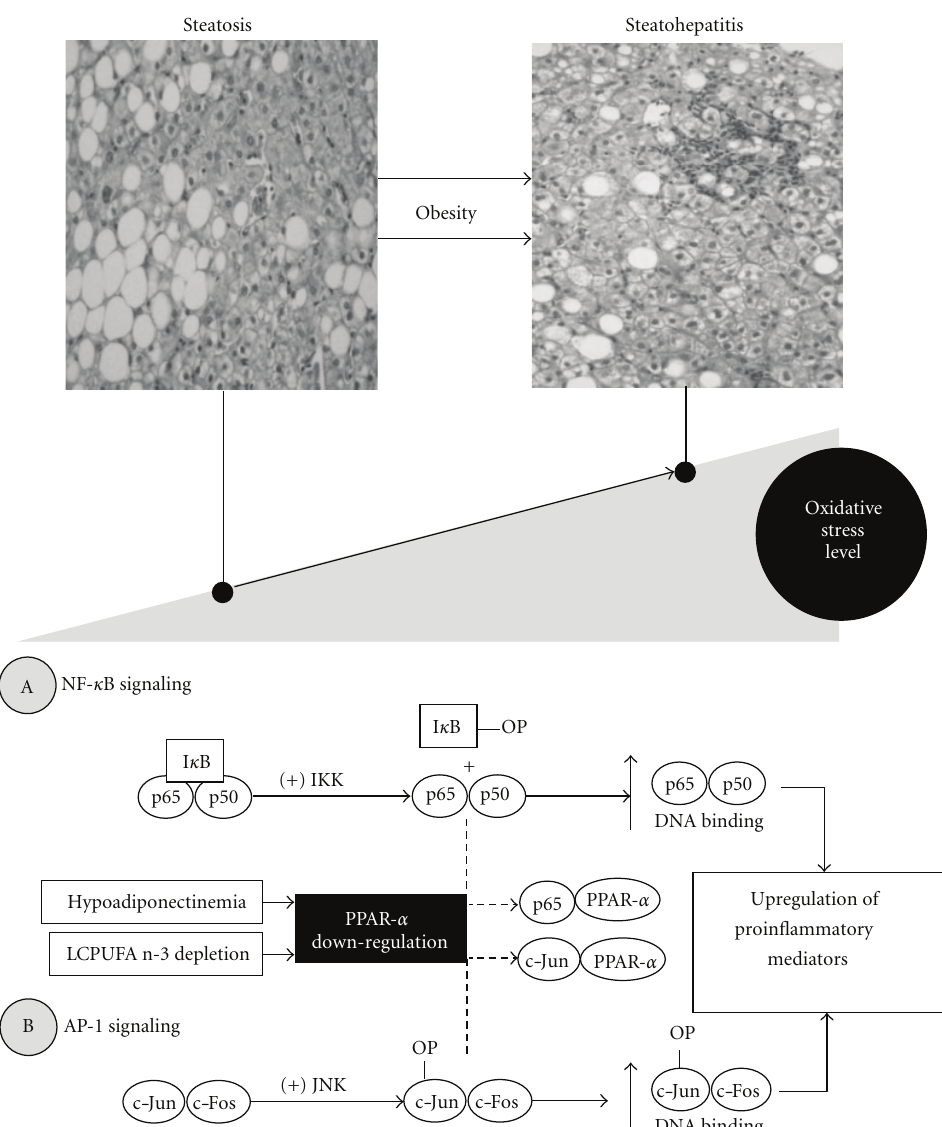
Figure 3: Interrelationships between the level of oxidative stress and PPAR- α downregulation in the progression of steatosis to steatohepatitis associated with obesity involving NF- κ B (A) and AP-1 (B) signaling. Abbreviations: AP-1: activating protein-1 (c-Jun-cFos; c-Jun-OP, phosphorylated c-Jun); I κ B: inhibitor of κ B (I κ B-OP, phosphorylated I κ B); IKK: I κ B kinase; JNK: c-Jun N-terminal kinase; LCPUFA, long- chain polyunsaturated fatty acid; NF- κ B: nuclear factor- κ B (p65-p50); PPAR- α : peroxisome proliferator-activated receptor- α . Solid arrows indicate enhanced contribution, whereas broken arrows indicate reduced